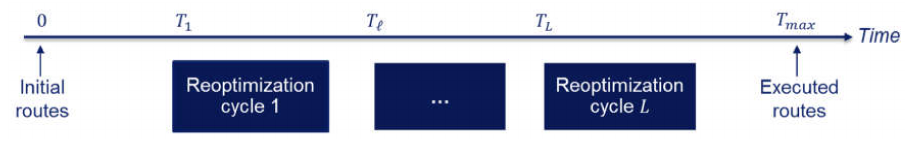
Figure 1. Re-optimization